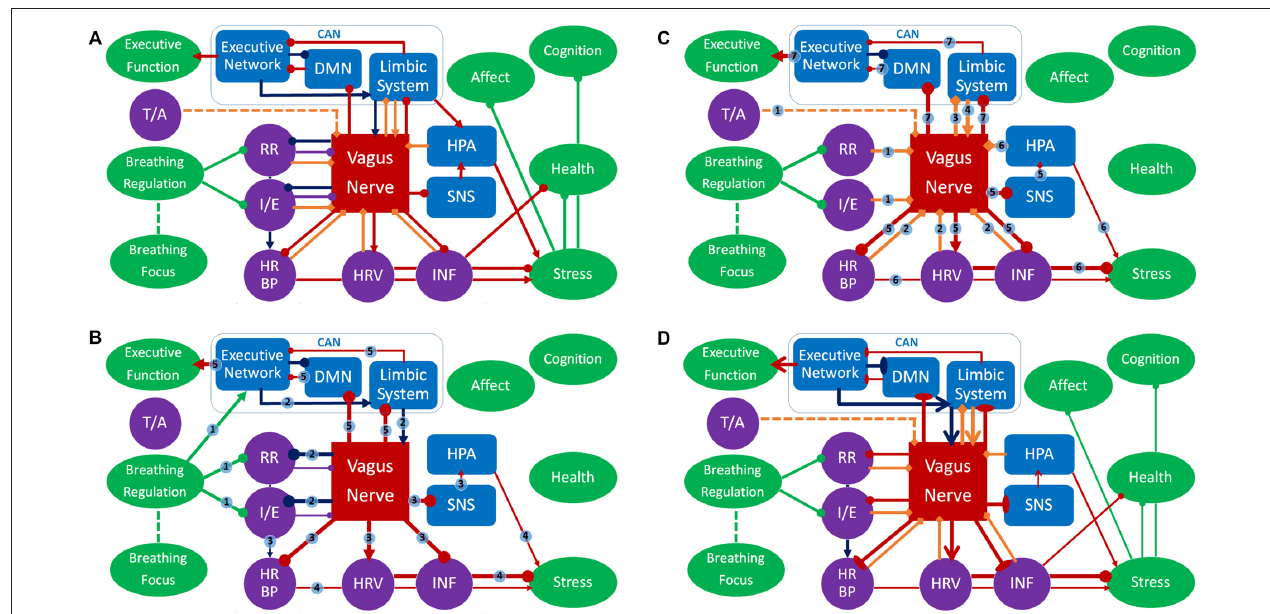
FIGURE 2 | Panel (A) represents an overview of the respiratory vagal nerve stimulation (rVNS) model of ContAct. See the text body for more details. There are two pathways through which respiration style stimulates VN: direct and indirect (biofeedback through afferent projections), shown in (B,C) respectively. (D) The tonic changes in the networks and the long-term effects. Color coding: red = VN, blue = other anatomy, purple = physiology, green = function, dark blue = direct route, orange = indirect route. Arrow-ends represent role: triangle = activating or increasing, circle = deactivating or decreasing, bladed = structural increase, ellipsis = structural decrease, diamond = afferent. Numbers on lines represent the temporal sequence during stimulation and the thickness of lines the phasic relative synaptic weight of the connection as a result. The dashed line represents the hypothetical afferent pathway of the thoracic/abdominal ratio to VN. RR, respiration rate; I/E, inhalation/exhalation ratio; T/A, thoracic/abdominal respiration ratio; HR, heart rate; HRV, heart rate variability; INF, inflammation state; SNS, sympathetic nervous system; HPA, hypothalamic pituitary adrenal axis; CAN, central autonomous network; DMN, default mode